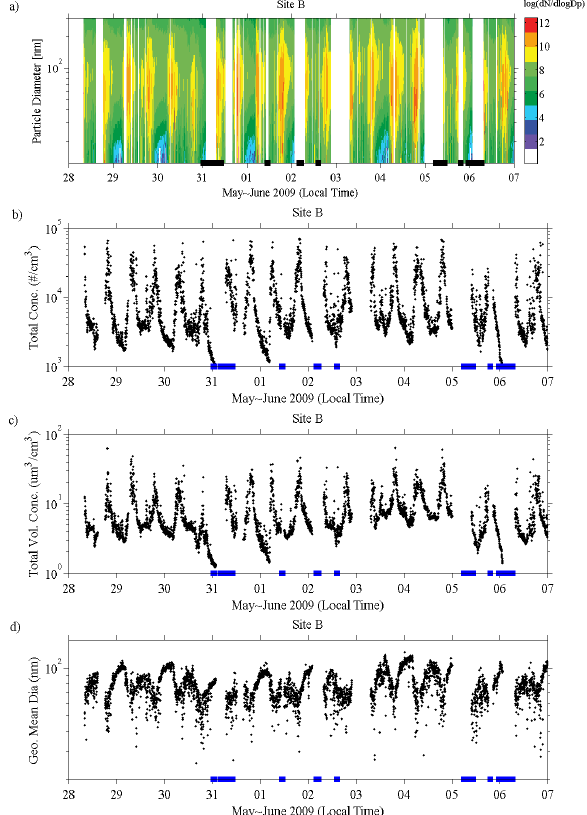
Fig. 3. Diurnal evolution of dry aerosol size distribution for Site A (Dhulikhel). (a) 2-D dry size distribution; (b) total number concentration [cm − 3 ]; (c) total volume concentration [nm 3 cm − 3 ] (d) Geometric Mean diameter [nm]. The discontinuities in the data are associated with electricity outages. The square dots (black/blue) on the bottom axis indicate precipitation events.